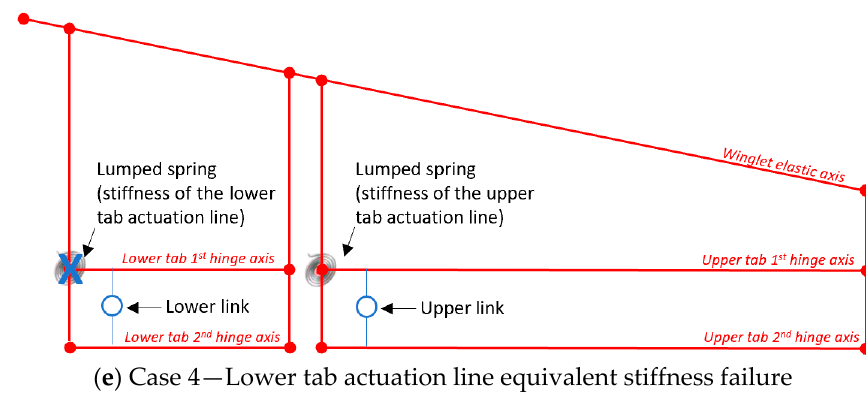
Figure 10. Failure cases of the morphing winglet.